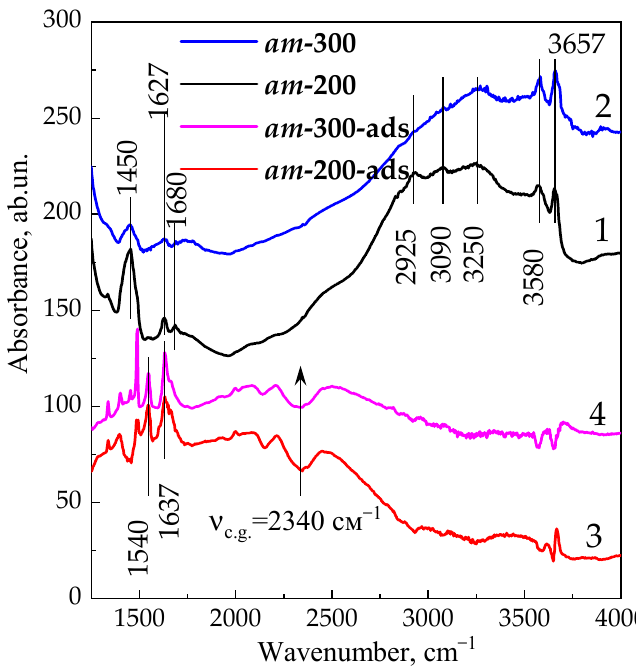
Figure 6. The IR spectra of samples am -200 (Curve 1) and am -300 (Curve 2), and the difference IR spectra obtained by subtracting Spectra 1 and 2 from the spectra taken after pyridine adsorption at 150 ° C, Curves 3 ( am -200-ads ) and 4 ( am -300-ads ).